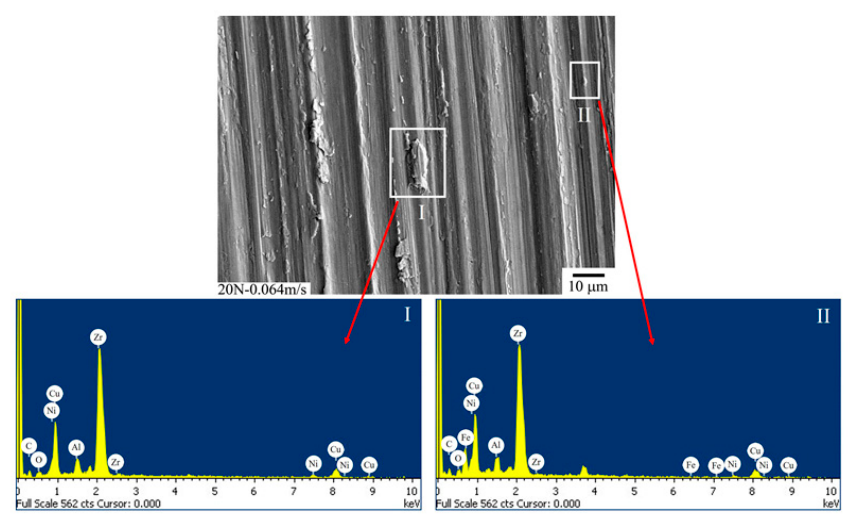
Figure 7. Scanning electron microscopy (SEM) image of a worn surface under a 20 N load, and the compositions of Debris I and II at a sliding velocity of 0.064 m /